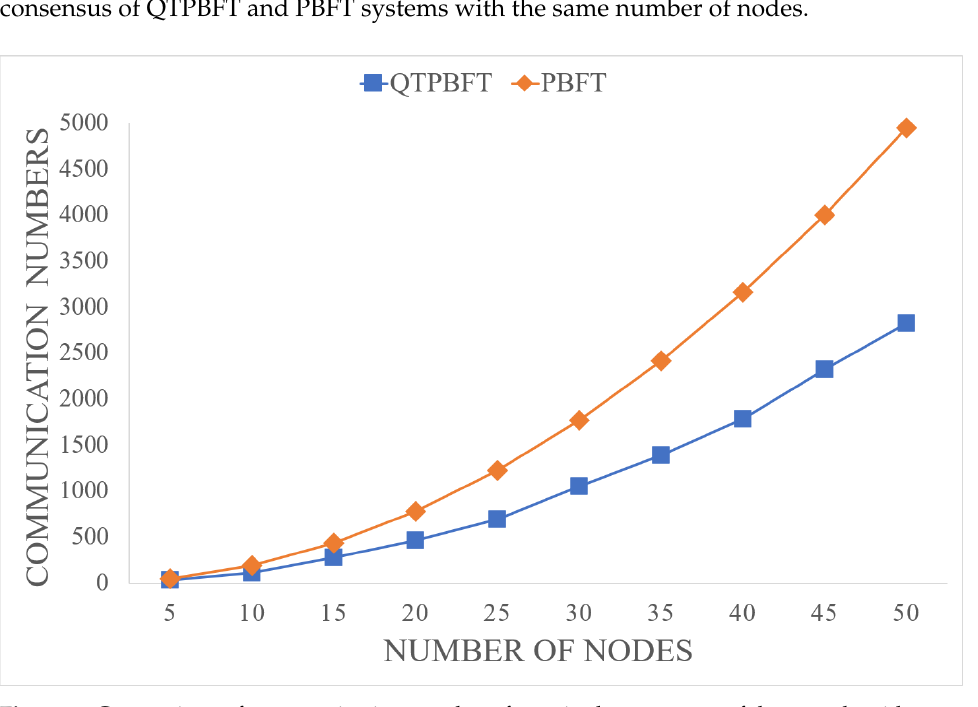
Figure 6. Comparison of communication numbers for a single consensus of the two